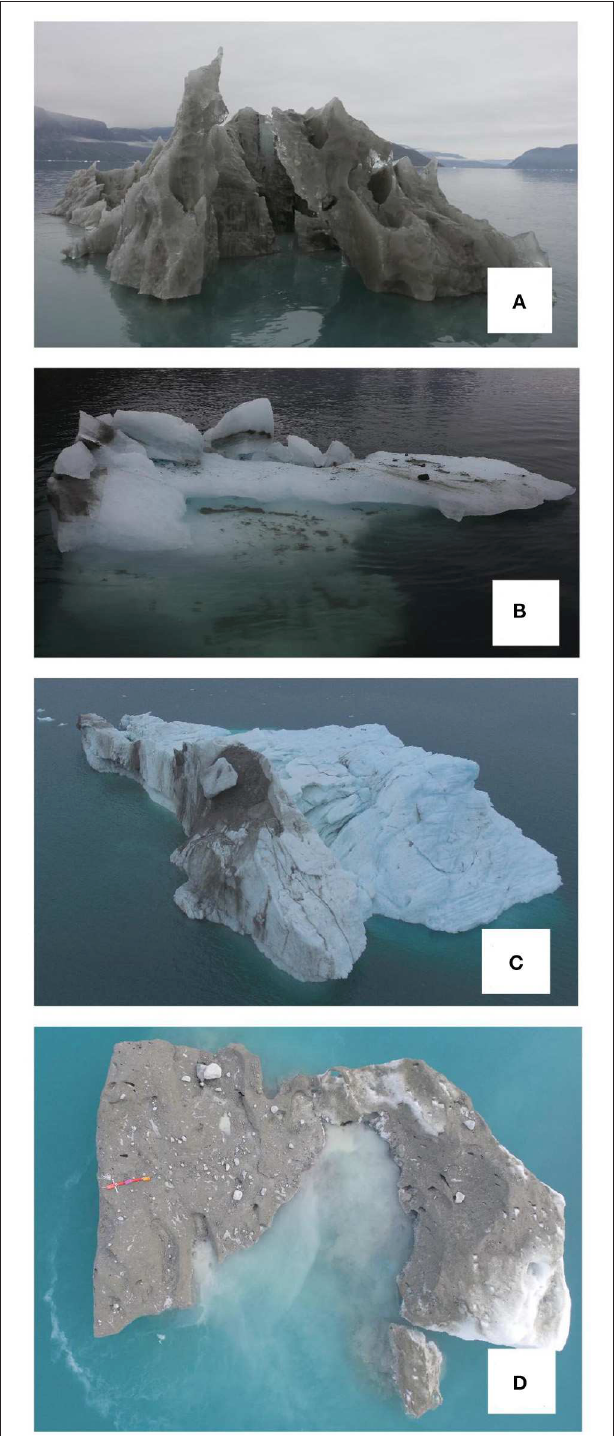
FIGURE 1 | Icebergs and their sedimentation patterns take on different forms in Greenland: (A) Fine-grained sediment frozen into the entire visible iceberg sail; (B) Narrow bands of fine-grained sediment and larger debris; (C) A freshly calved iceberg shows a sediment layer from the top of its parent glacier; (D) A melting, sediment-laden bergy bit with larger stones and debris. Its turbid meltwater plume is also